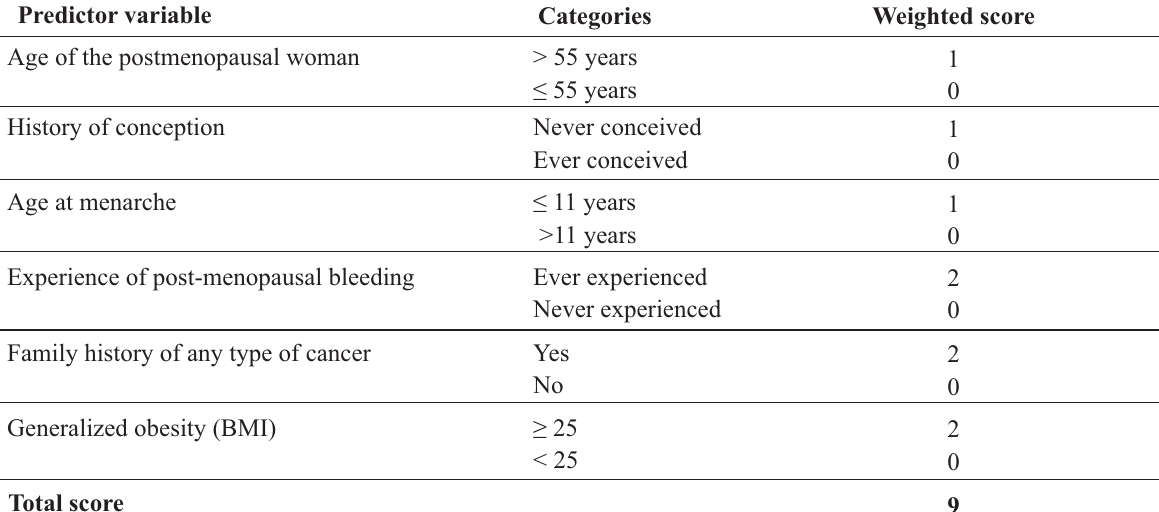
Table 1: Predictor variables in the final risk prediction model Predictor variable